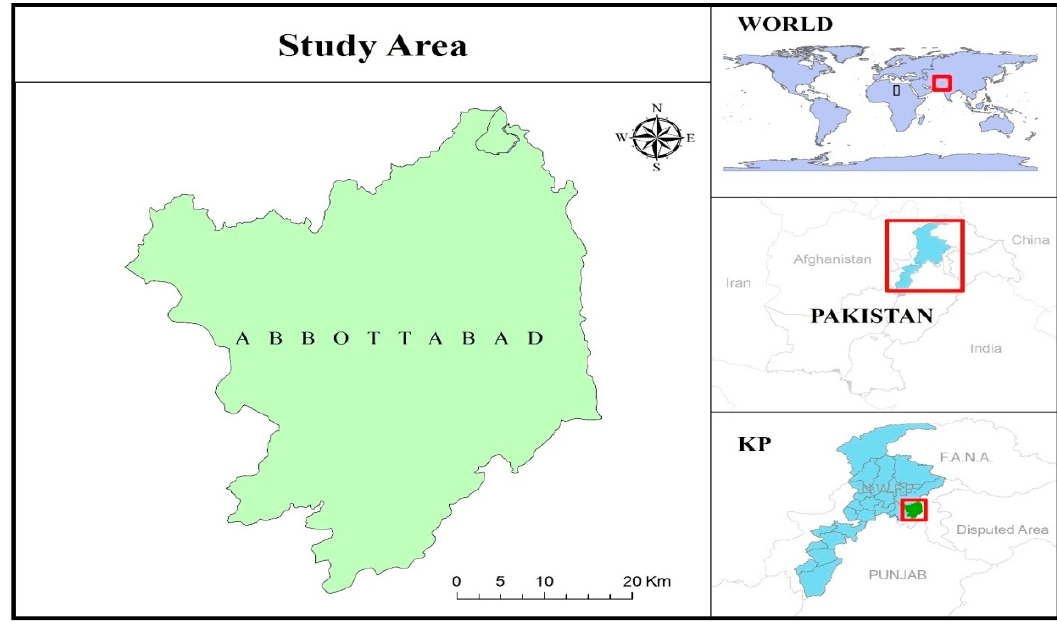
Figure 1. Study area.